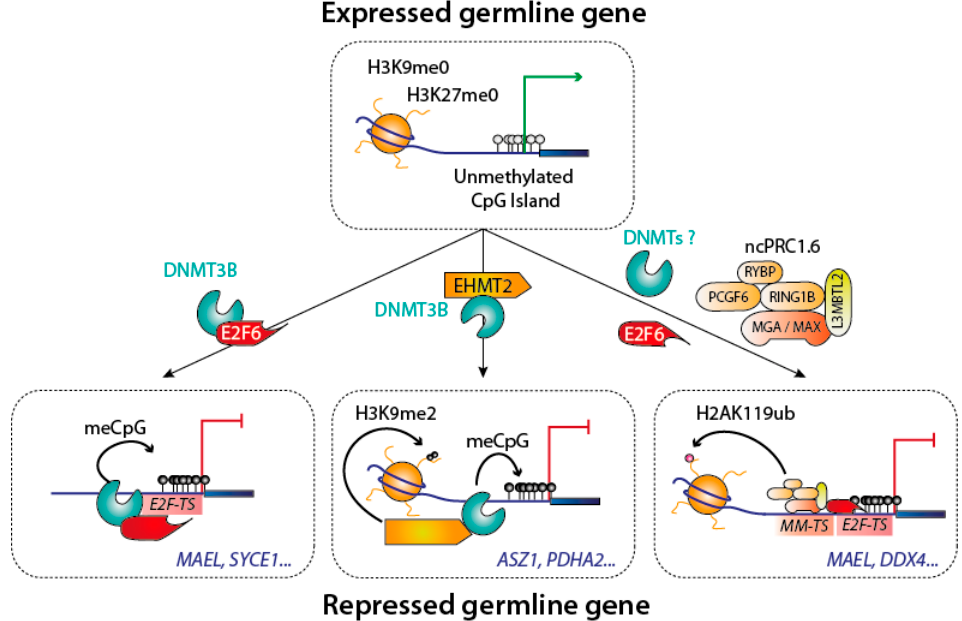
Figure 6. Silencing of the germline genes during implantation. Different complexes are involved in the silencing of germline genes. Three well documented mechanisms are shown, with some example of known targeted germline genes in blue. Abbreviations used: E2F-TS : E2F target sequence; MM-TS : MGA-MAX target sequence.